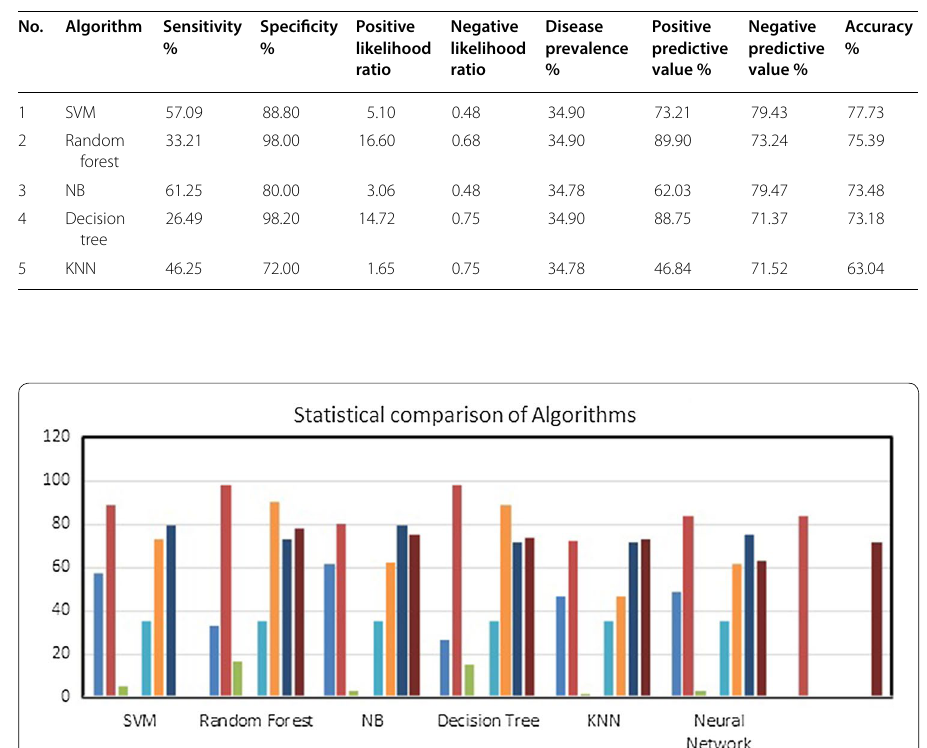
Fig. 10 Statistical comparison of